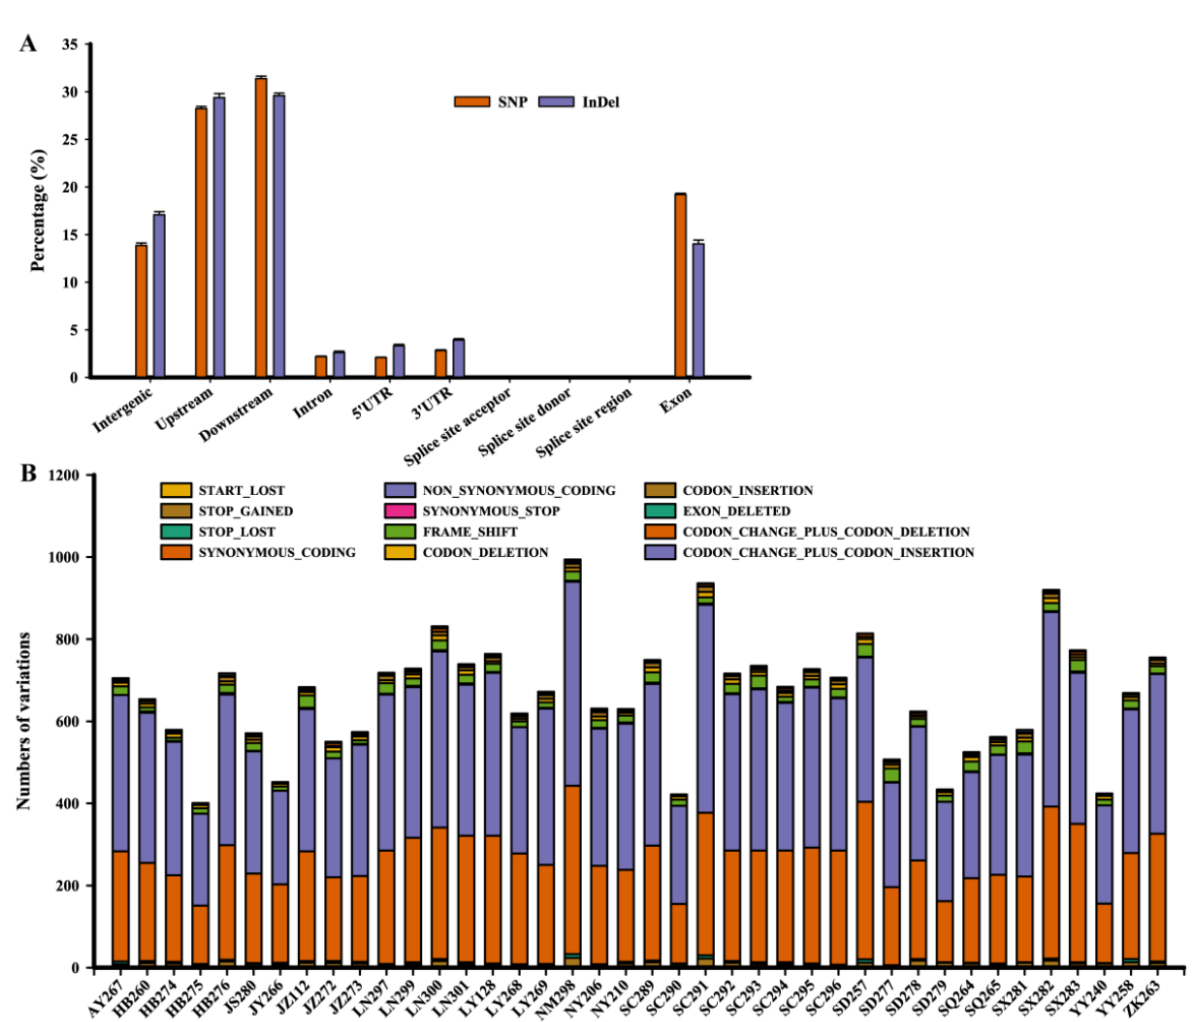
Figure 3. Genome-wide distribution and types of variations (identified by comparison with the reference genome of isolate YY187) within all D. arachidicola isolates. ( A ) Genome-wide percentage distribution of SNPs and InDels within different genomic regions, respectively. Each bar indicates the average percentage of variations in a certain genomic region among all the isolates, with the error bars showing the standard error of the mean; ( B ) the proportion of different variation types in the CDS region of D. arachidicola isolates.